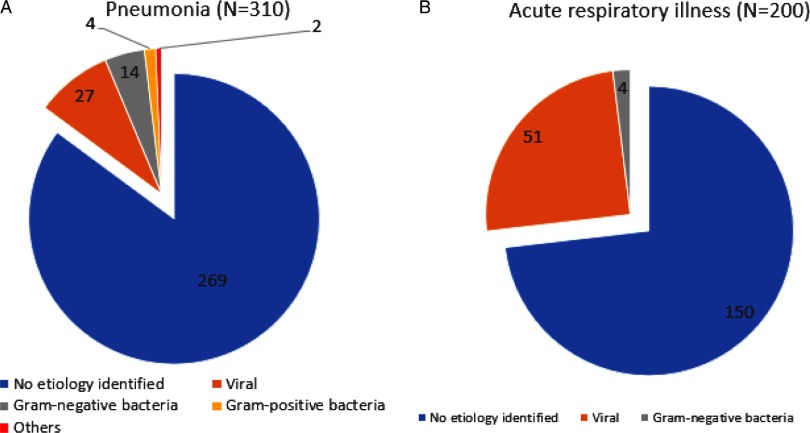
Microbiologic etiology identified for patients with pneumonia/upper respiratory tract illness (URTI) admitted to general medicine respiratory surveillance wards in an acute tertiary hospital during a COVID-19 outbreak.